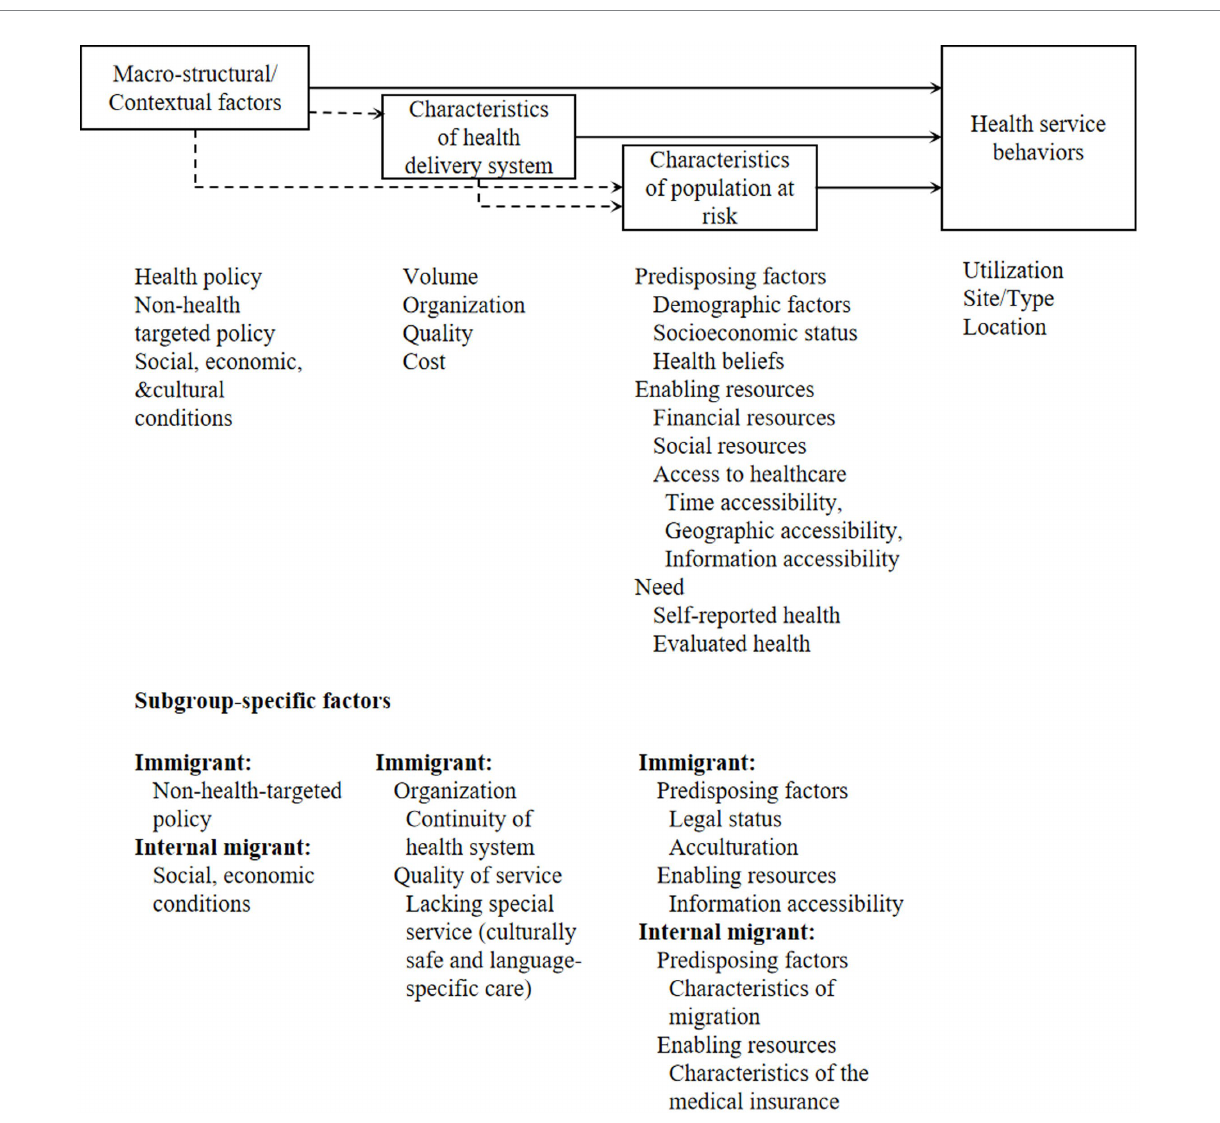
FIGURE 1 An analytical framework for migrants' health service behaviors. A solid line denotes a direct effect; a broken line indicates that some of the factors within this category have an indirect effect on the outcomes of migrants' health service